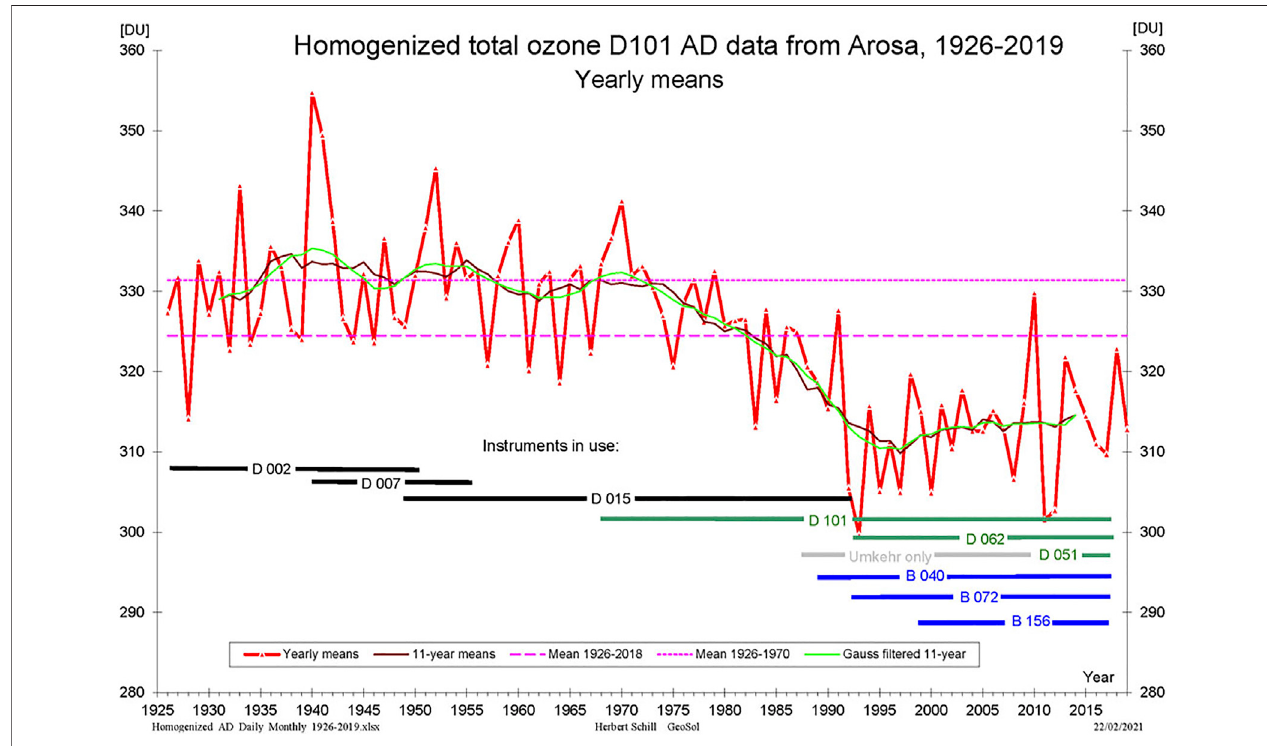
FIGURE 1 | Homogenized total column ozone from Arosa and Davos (Switzerland), 1926 – 2019. Adapted from Rozanov et al.